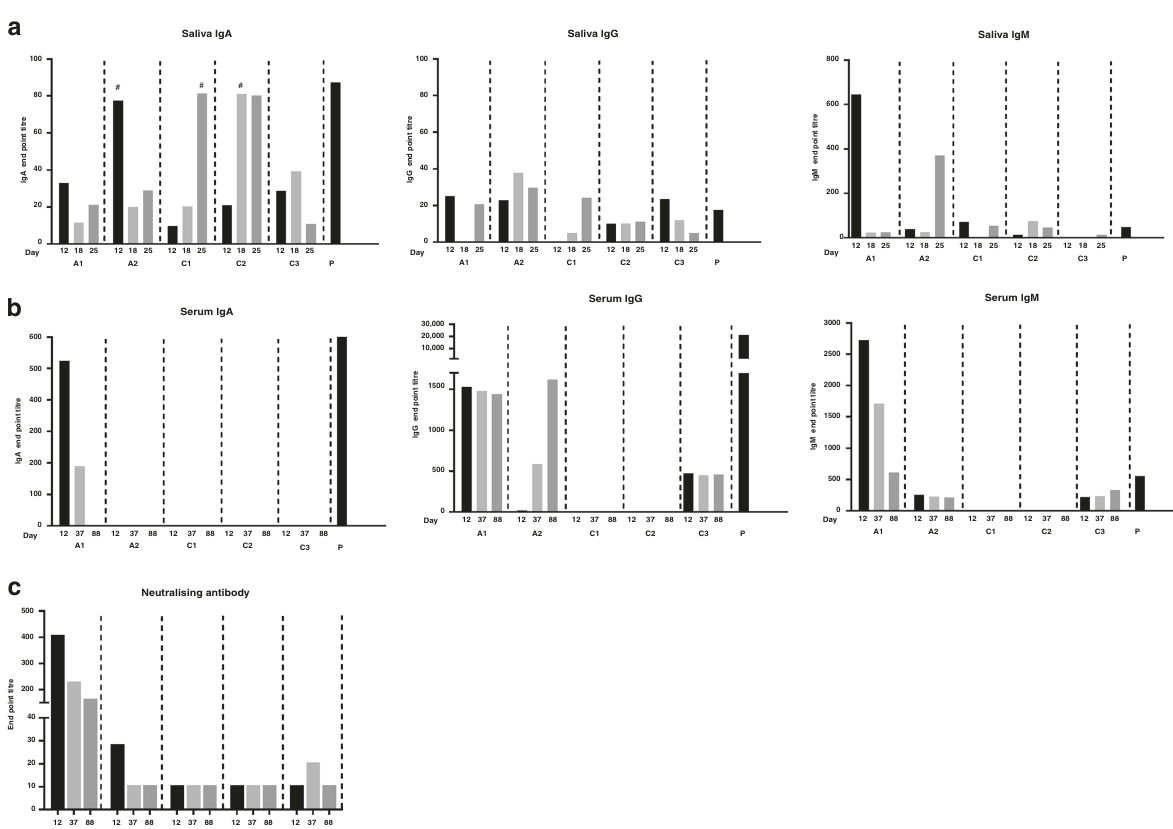
Fig. 3 Salivary and plasma antibody responses against SARS-CoV-2 S1 protein by ELISA and by microneutralization assay. a Anti-S1 salivary IgA, IgG, and IgM. # IgA anti-S1 response that developed concurrent with resolution of symptoms. b Anti-S1 plasma IgA, IgG, and IgM. c Neutralizing antibody activity in plasma. A1: mother, A2: father, C1: male (9 years), C2: male (7 years), C3: female (5 years), (P) positive